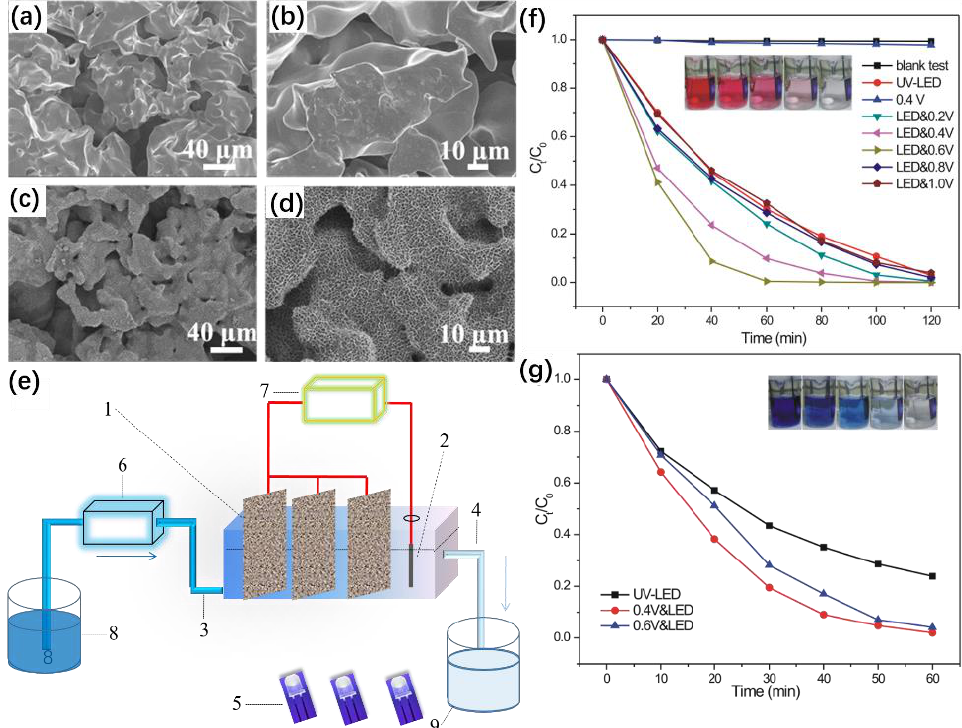
Figure 5. ( a , b ) SEM images of porous Ti. ( c ) Na2Ti 3 O 7 /porous Ti. ( d ) SEM images of the cross-section of TiO 2 /porous Ti with different magnifications. ( e ) Schematic diagram of the experimental reactor system: 1—TiO 2 /porous Ti, 2—Pt wire electrode, 3—water inlet, 4—water outlet, 5—UV-light-emitting diodes (LEDs), 6—peristaltic pump, 7—electrochemical workstation, 8—sewage pool, and 9—recovered water pool. ( f ) C t /C 0 vs. t and ( g ) MB degradation (20 mg/L) using TiO 2 /porous Ti under photoelectrocatalysis (PEC) conditions. Copyright © 2017 Elsevier